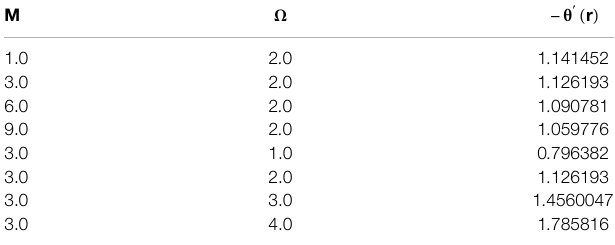
TABLE 4 | Behavior of Nusselt number against M and Ω .